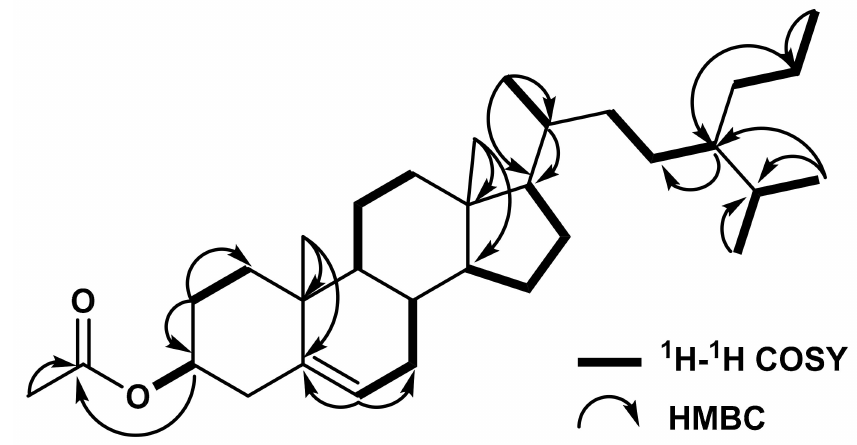
Figure 2. Selected 1 H- 1 H COSY and HMBC correlations for 1